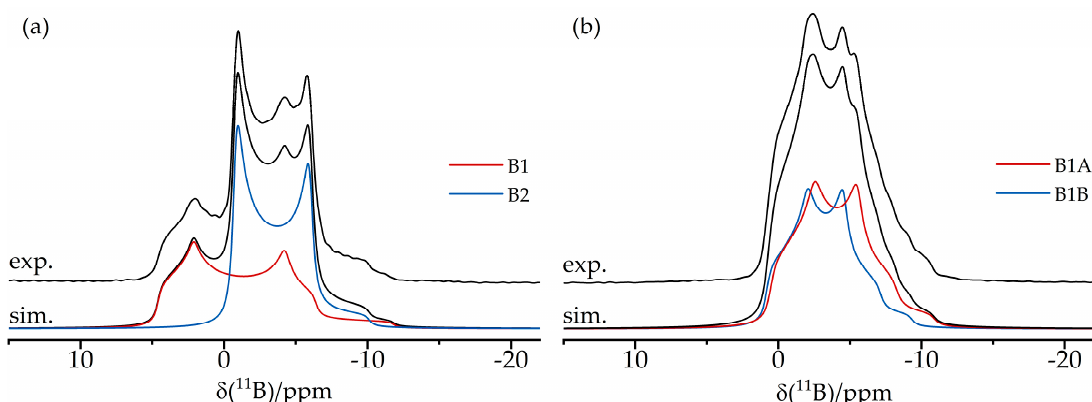
Figure 25. Experimental and simulated 11 B MAS NMR spectra of ( a ) the monomeric compound 8 and ( b ) the tetrameric FLP–CO 2 adduct 7 .